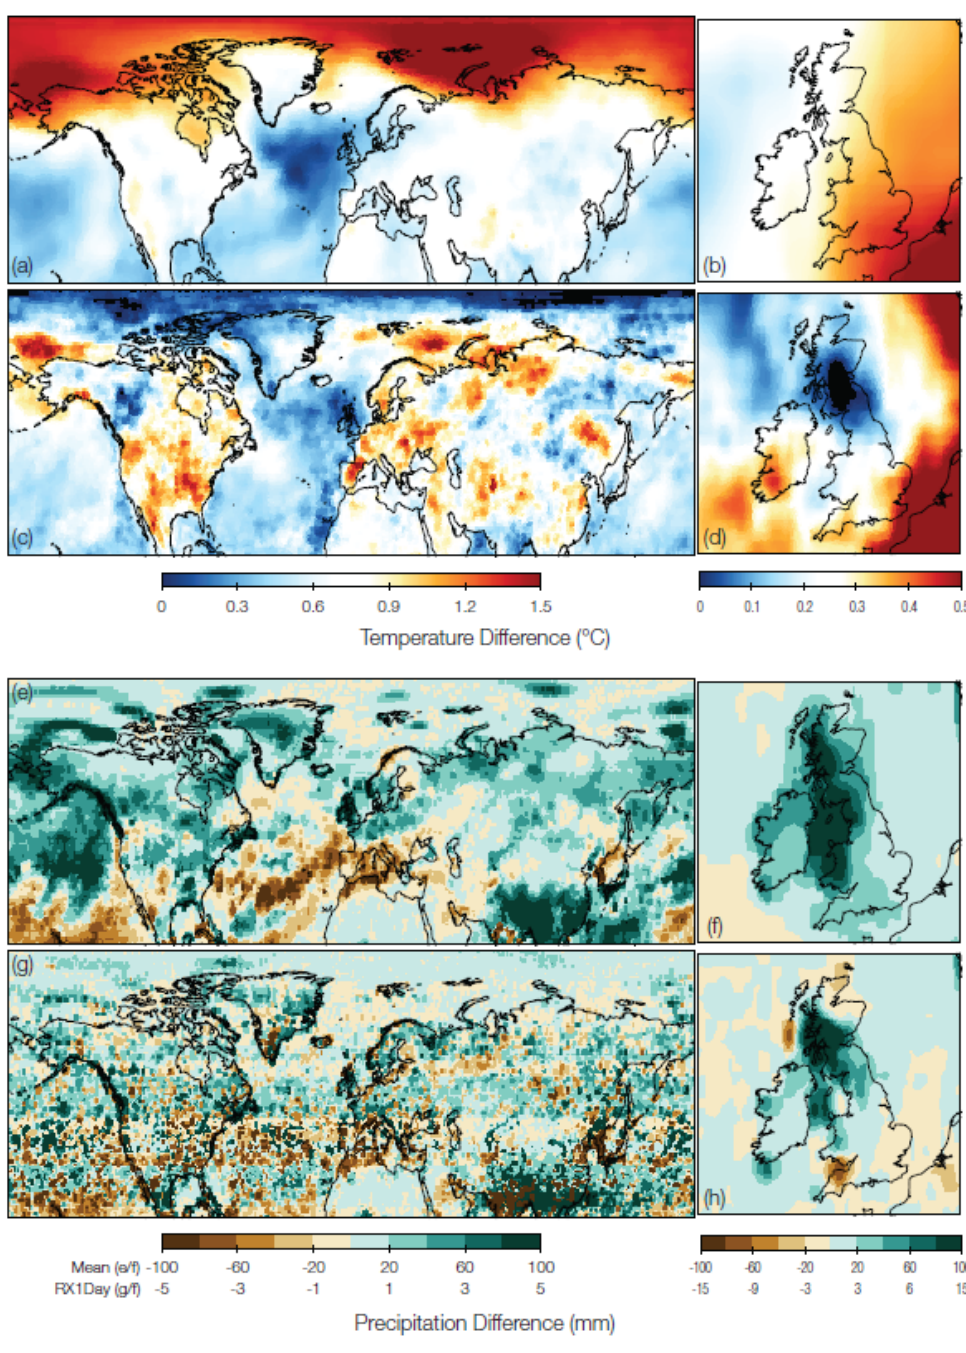
Figure 7. The composite difference between the 2 °C and 1.5 °C above pre-industrial worlds (the ensemble mean of all model years for the years which qualified as a 1.5/2 °C world using our criteria) for: ( a , b ) TX; ( c , d ) TXx; ( e , f ) annual mean precipitation; and ( g , h ) RX1Day.